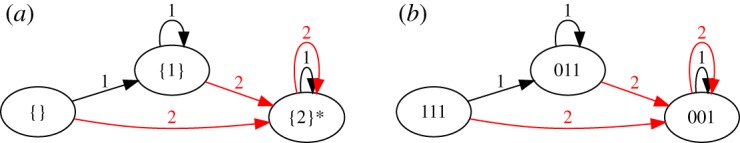
Mullins effect. (a) Minimal schematic representation starting from a featureless state, as in figure 1. The state {2}* is incapable of having a memory of 1 written in it. (b) Transition graph for the park bench model with N = 2, hinit = 1. A single memory is encoded where the grass height switches from 0 to a plateau of 1. (Online version in colour.)